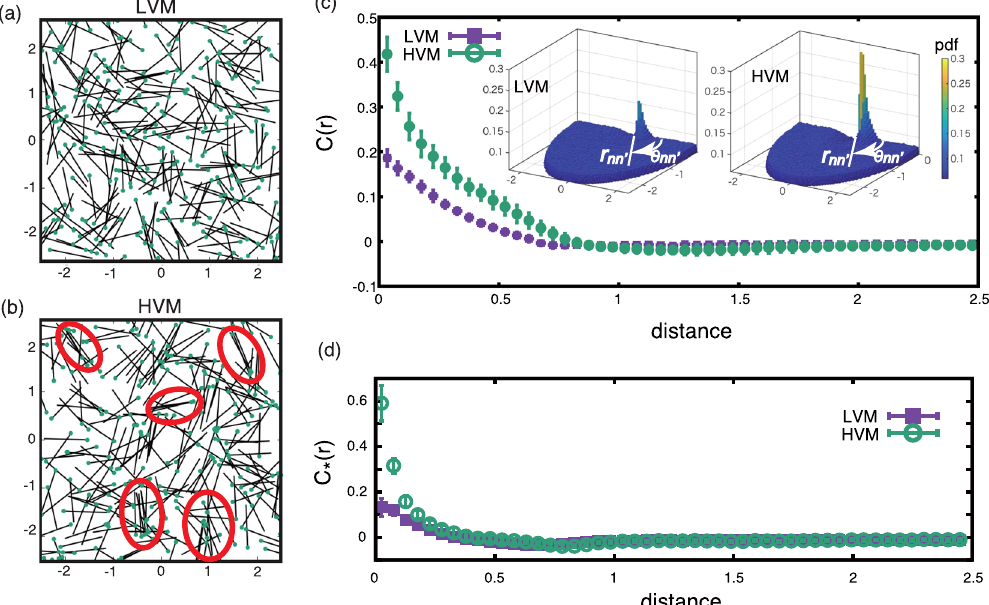
Figure 3. Snapshots of cell configurations for the simulation of N = 250 sperm cells with a domain length of L = 5, no averaging and the temporally varying velocity profile associated with the mean and the first M = 2 flow PCA modes. ( a ) The LVM case. The dots and the rods illustrate the position of each cell head and the associated cell orientation. ( b ) The HVM case, analogous to ( a ), with clustering cells highlighted by red circles. (Also see SM Movies). ( c ) The alignment ordering function, C ( r ), and ( d ) the clustering order function, same simulations as ( a , b ), with bars denoting the standard error. (( c ), inset) The predicted probability density functions for these simulations; the horizontal plane of the plots consists of the polar coordinates, r nn ′ , θ nn ′